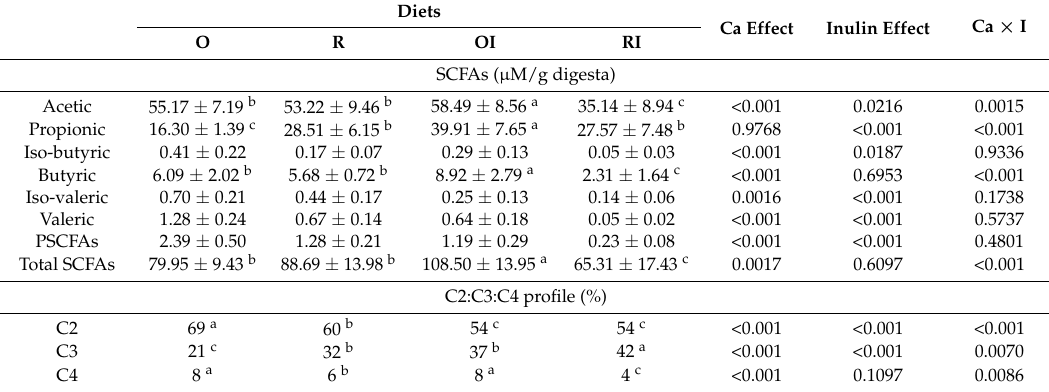
Table 3. The concentration of short chain fatty acids (SCFAs), putrefactive SCFAs (PSCFAs) and their profiles in the caecal digesta of rats fed experimental GFDs *.